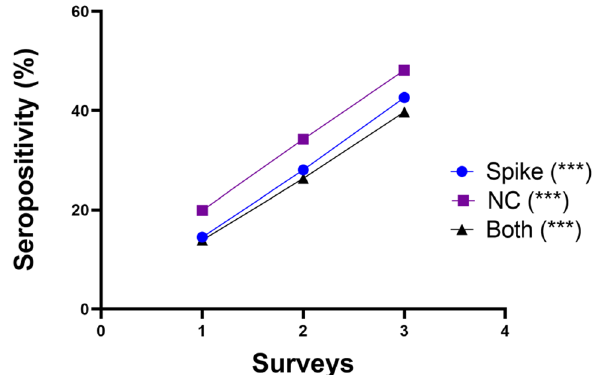
Figure 2. Trend plot of seropositivity for both spike and NC between November 2020 and July 2021. ***P < 0.001 (Cochran–Armitage test for